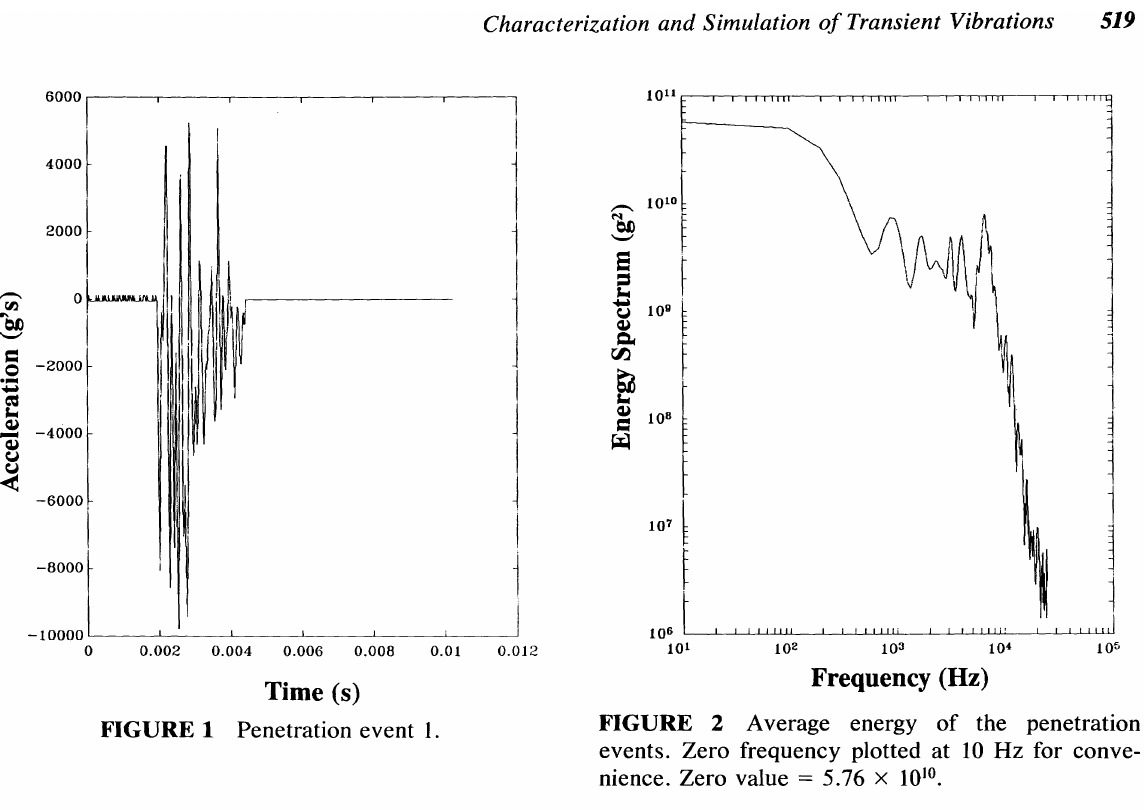
FIGURE 1 Penetration event 1. FIGURE 2 Average energy of the penetration events. Zero frequency plotted at 10 Hz for conve nience. Zero value = 5.76 x